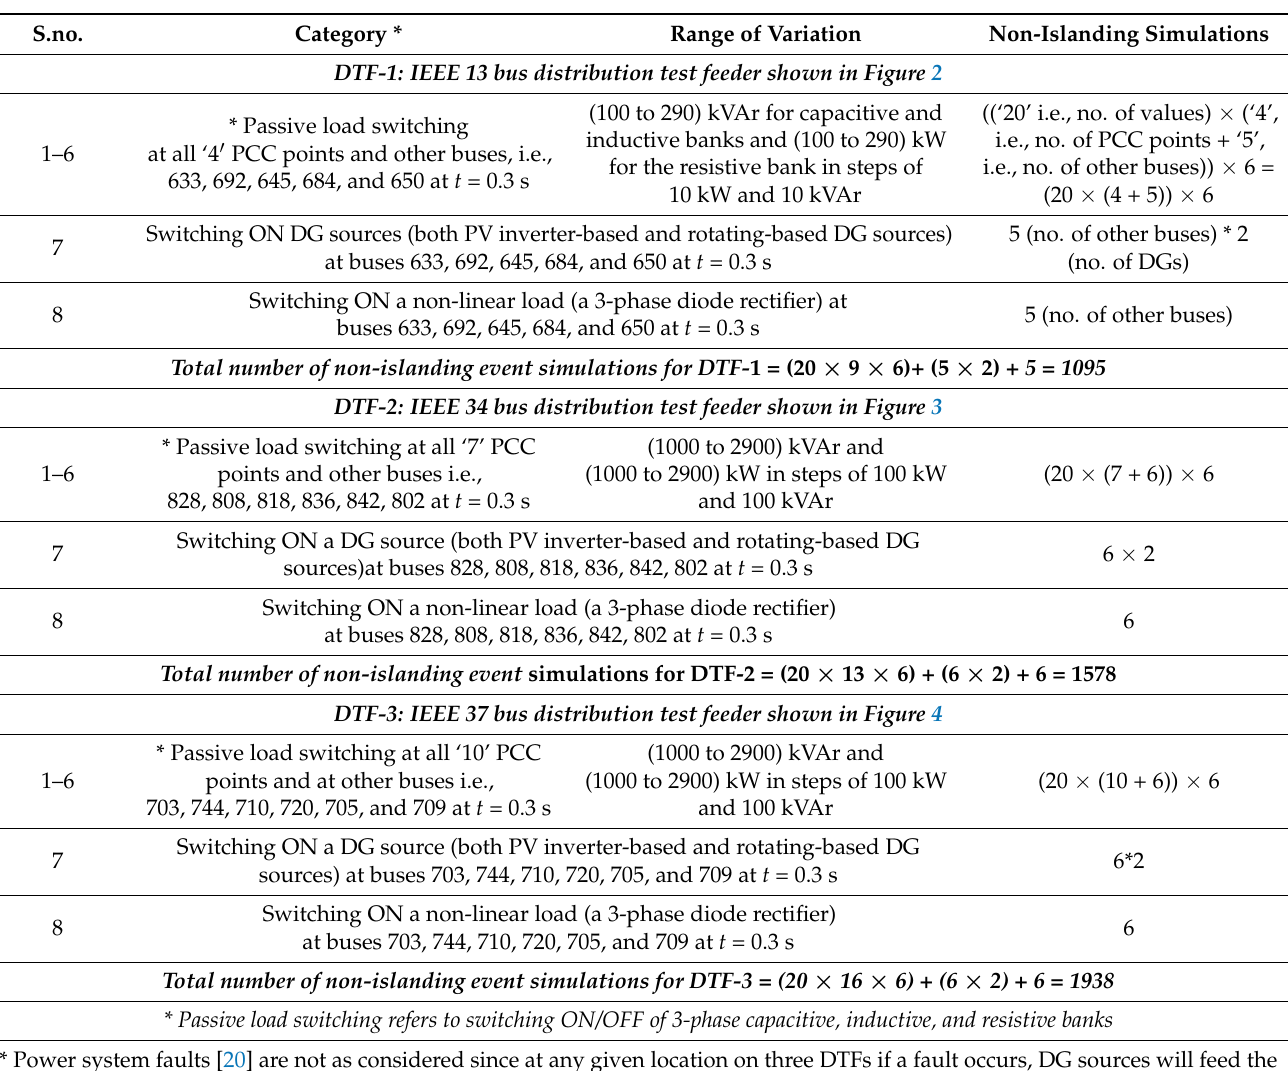
Table 4. Non-islanding switching events and the total number of